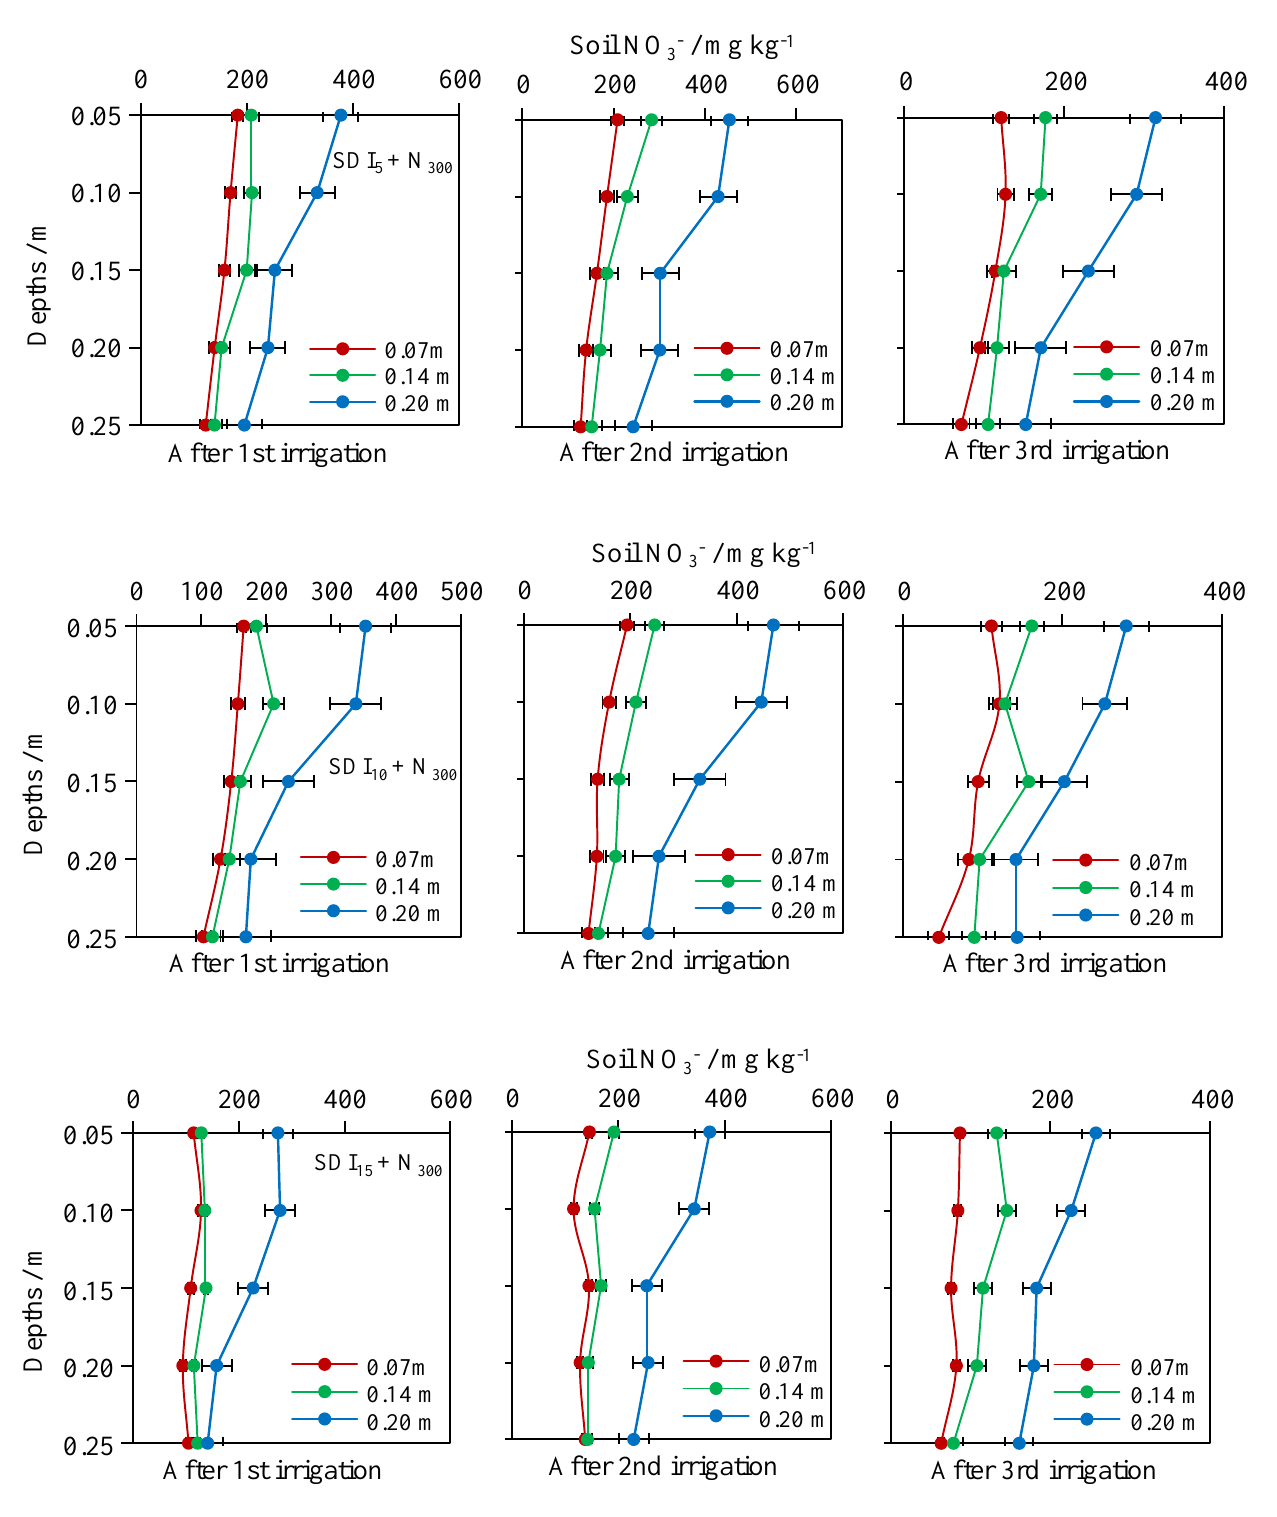
Figure 7. Soil NO 3 − -N after three irrigation events occurring from different emitter depths under the 300 kg N ha −1 fertilization rate. Error bars represent standard error.